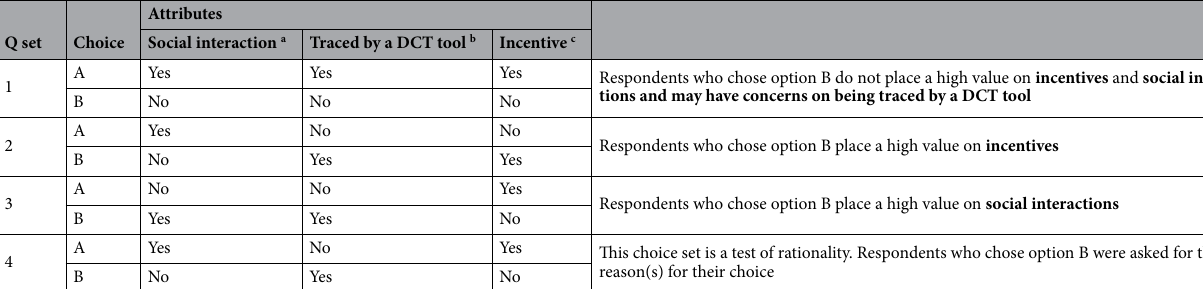
Table 3. Discrete choice experiment choice sets. a Social interaction: Ability of the respondent to engage in social activities when a lockdown was not in force. b Traced by a DCT tool: Whether close contact within 2 m had occurred between 2 devices were captured due to the carrying of a DCT tool. Negative attribute. c Incentive: Any incentive (e.g., monetary, virtual rewards, lucky draw) which the respondent thought was reasonable to spur him/her to carry a DCT tool and/or to reduce his/her social activities. DCE indicates discrete choice